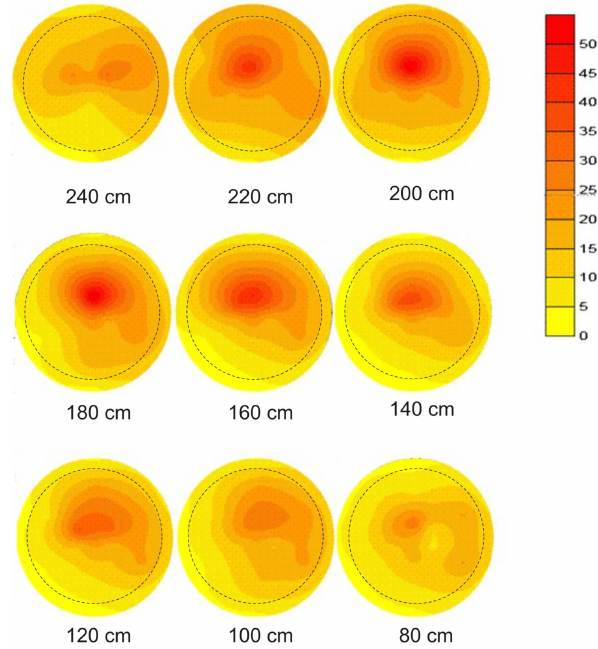
Fig. 5. Light intensity homogeneity measurements inside the cham- ber in arbitrary unit. Each disk represents one horizontal section measurement. The first section (top-left) was measured at the low- est level of the chamber. Indicated lengths are the vertical distance between the considered slice and the horizontal plane defined by the three arc-lamps. Note: inside the dash-lined circle, the contour plots have been created by interpolation between measurements. Outside the dashed line, values are not measured but